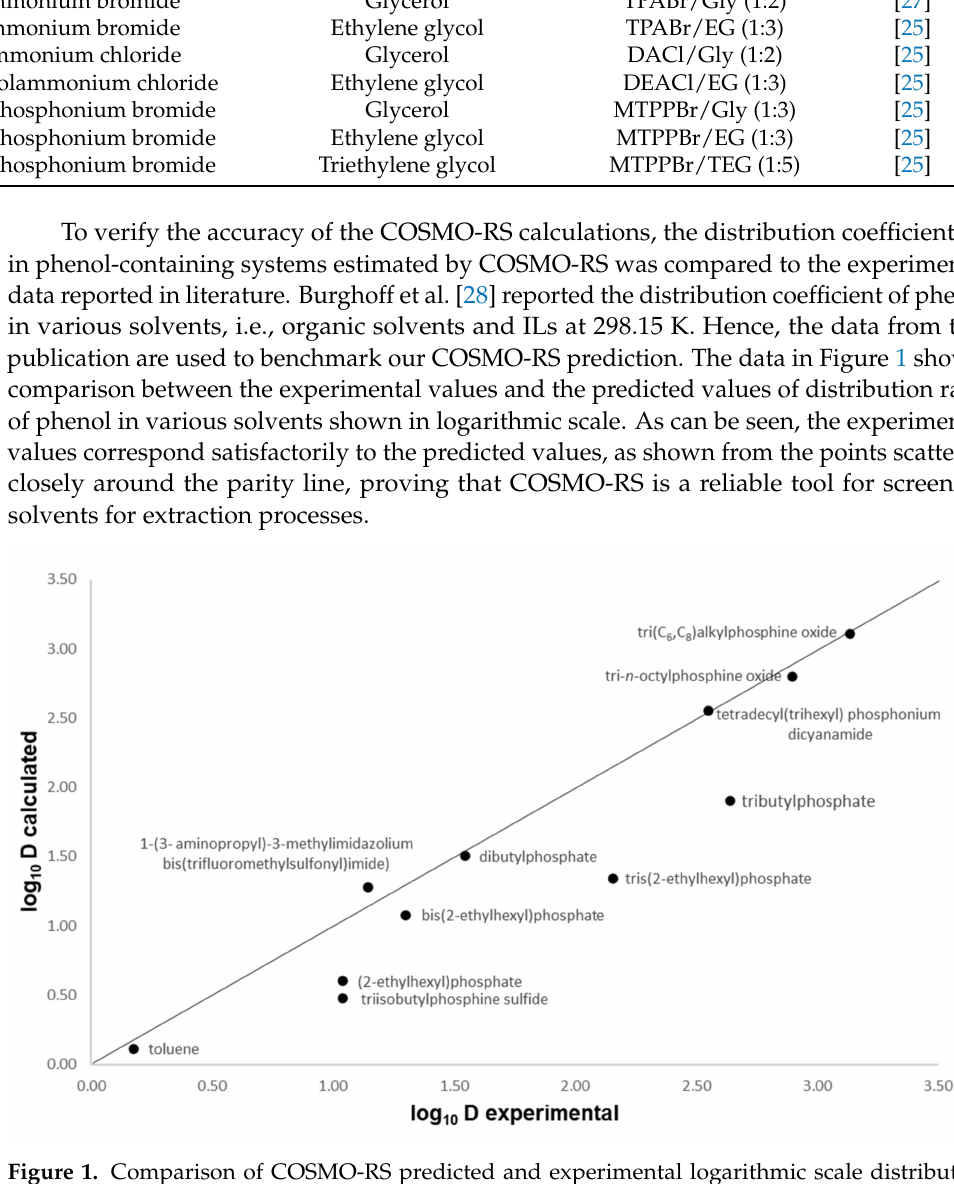
Figure 1. Comparison of COSMO-RS predicted and experimental logarithmic scale distribution coefficients (log 10 D) of phenol in various